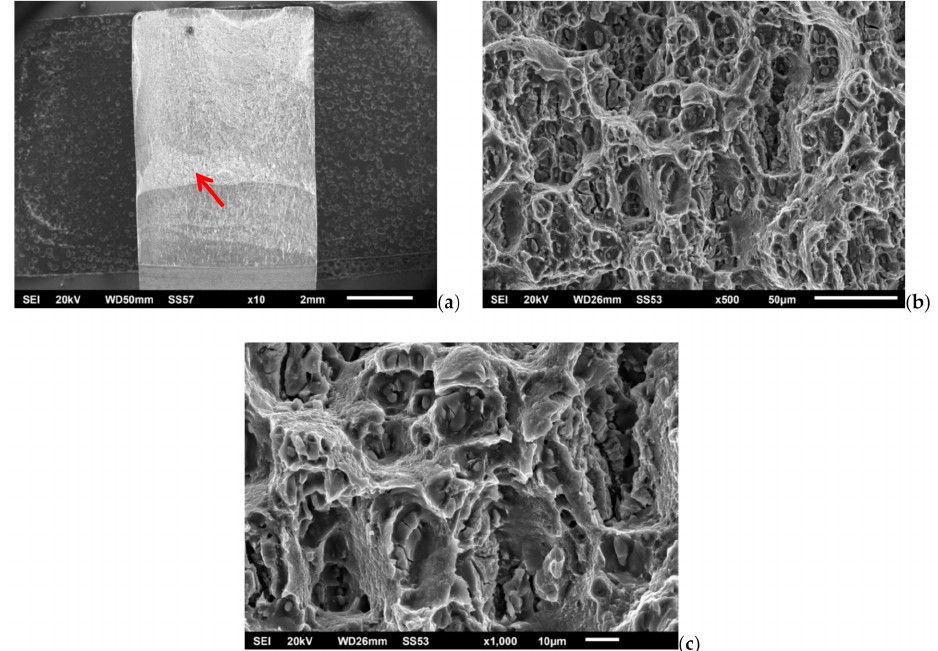
Figure 12. Fracture surface of the B-AS specimen: ( a ) macro, ( b ) and ( c ) stable crack growth